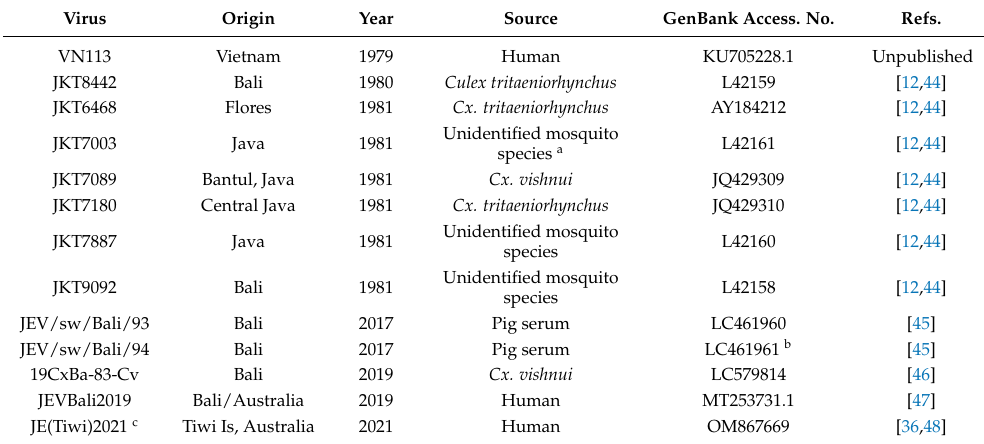
Table 1. All known isolates of Japanese encephalitis virus genotype 4 from